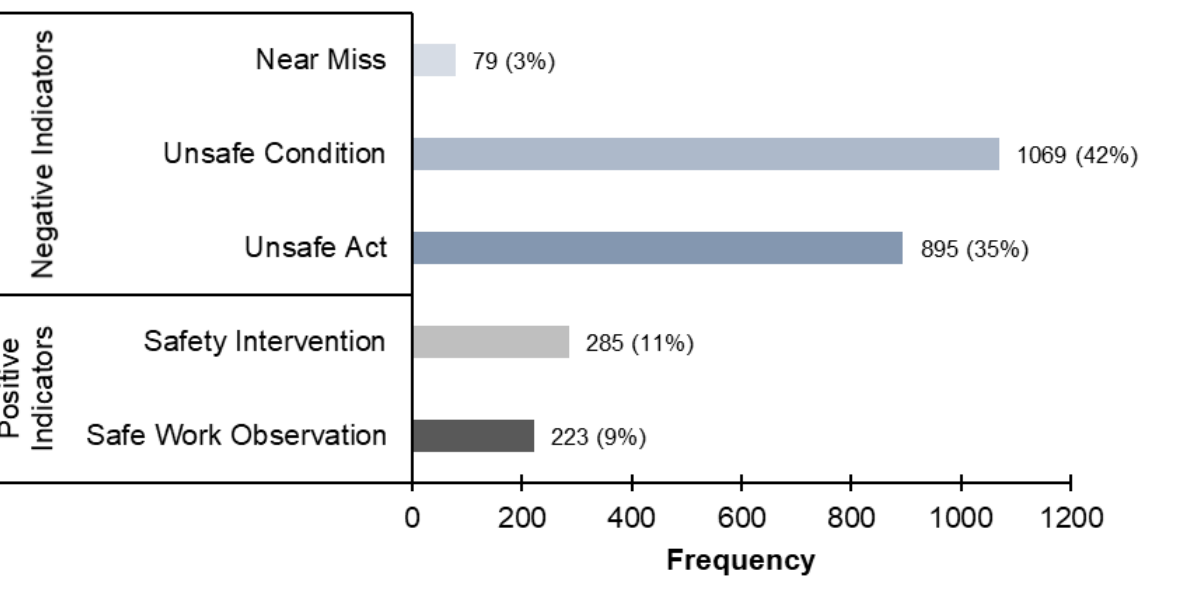
Figure 3. Statistics of safety leading indicators.